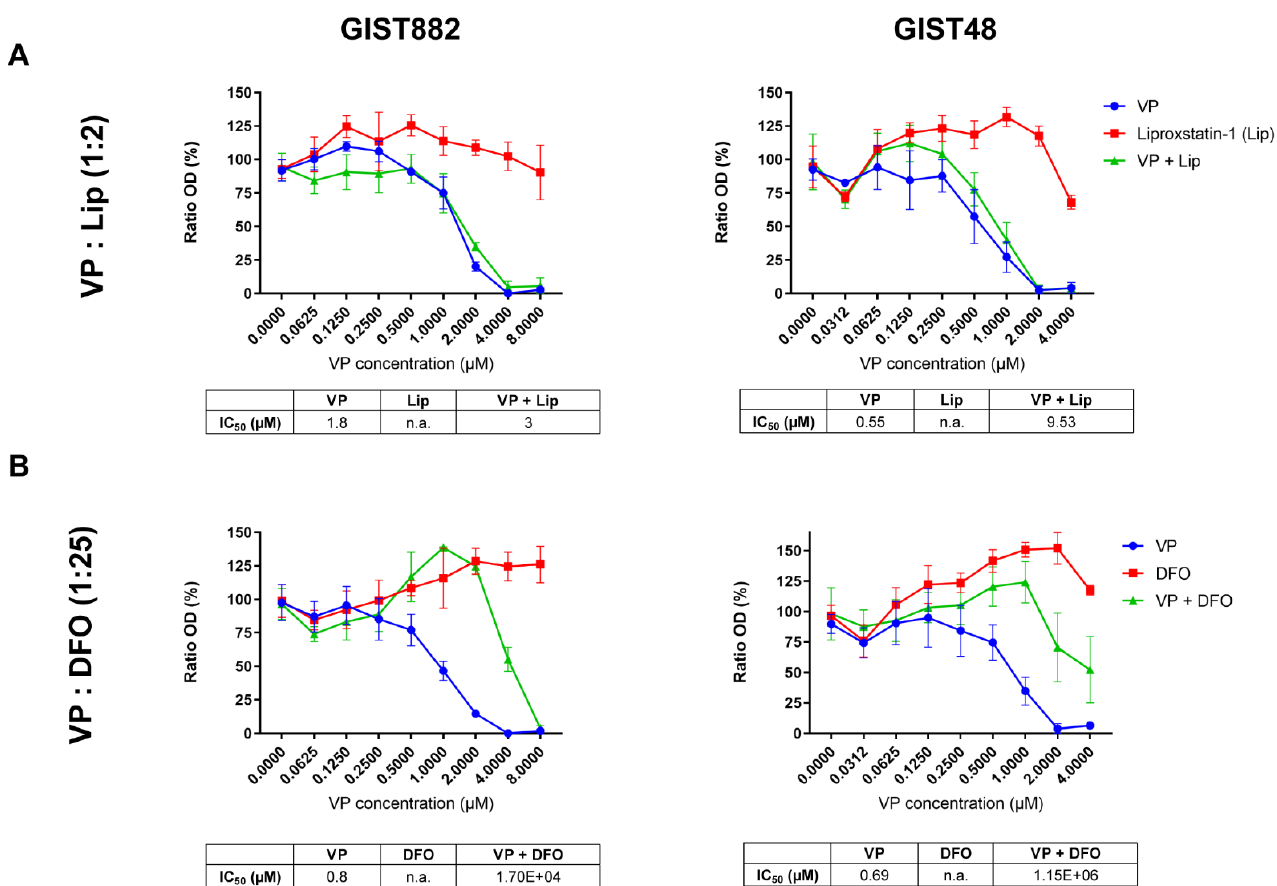
Figure 3. VP induces a massive loss of cell viability, which is reduced in the presence of DFO in both GIST882 and GIST48 cell lines. WST-1 viability assays in GIST882 and GIST48 are shown in the left and right panels, respectively. ( A ) Cells were treated for 24 h with a combination of different concentrations of VP and liproxstatin (Lip), an antioxidant, with a 1:2 ratio, or ( B ) with a combination of different concentrations of VP and DFO, an iron chelator, with a 1:25 ratio. IC50 values are shown in tables under the viability graphs. Mean values ±SD are shown for three or four independent experiments with three technical replicates for each experiment.